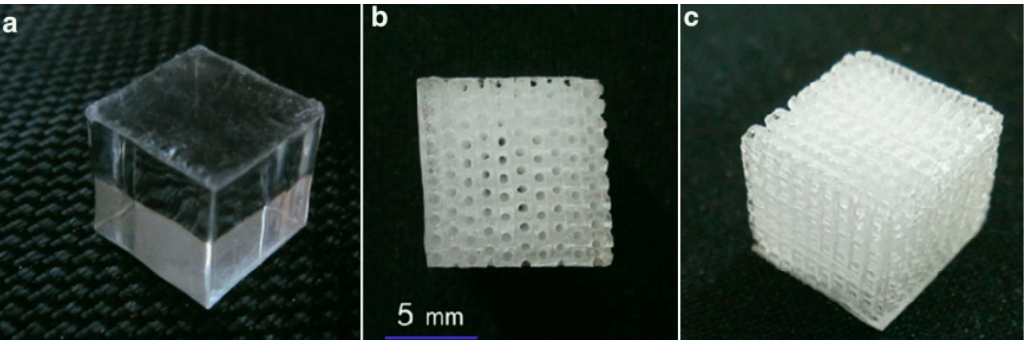
Figure 4. Bulk cubic specimen before 3D printing (3DP) laser processing ( a ). A front view of the fabricated PMMA scaffold showing regular pattern of holes ( b ). An isometric view of the scaffold showing inward 3D network ( c ).